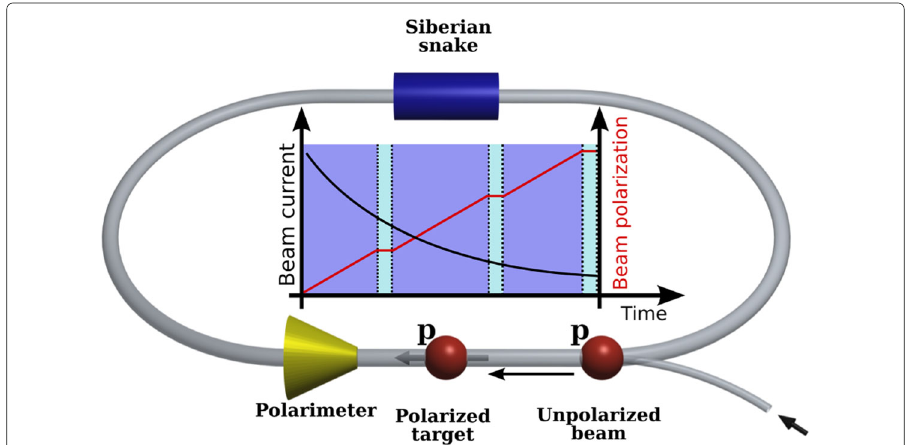
Fig. 2 Cycle scenario for longitudinal spin-filtering. The time intervals of spin-filtering (light-blue) alternate with other where the beam polarization is measured by reversing the longitudinal target polarization (magenta)